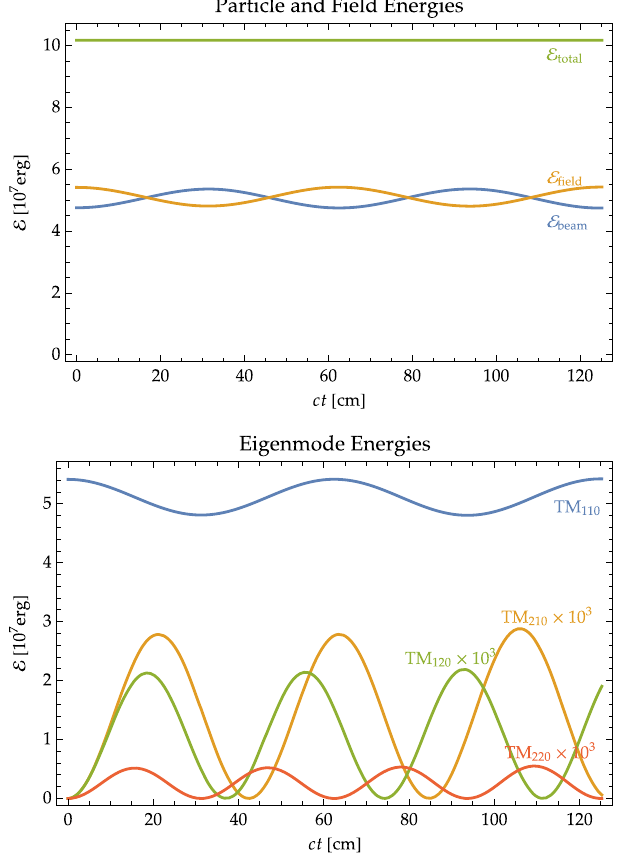
FIG. 3. Total particle-field energy and individual mode energies for the four-particle configuration in a longer cavity.